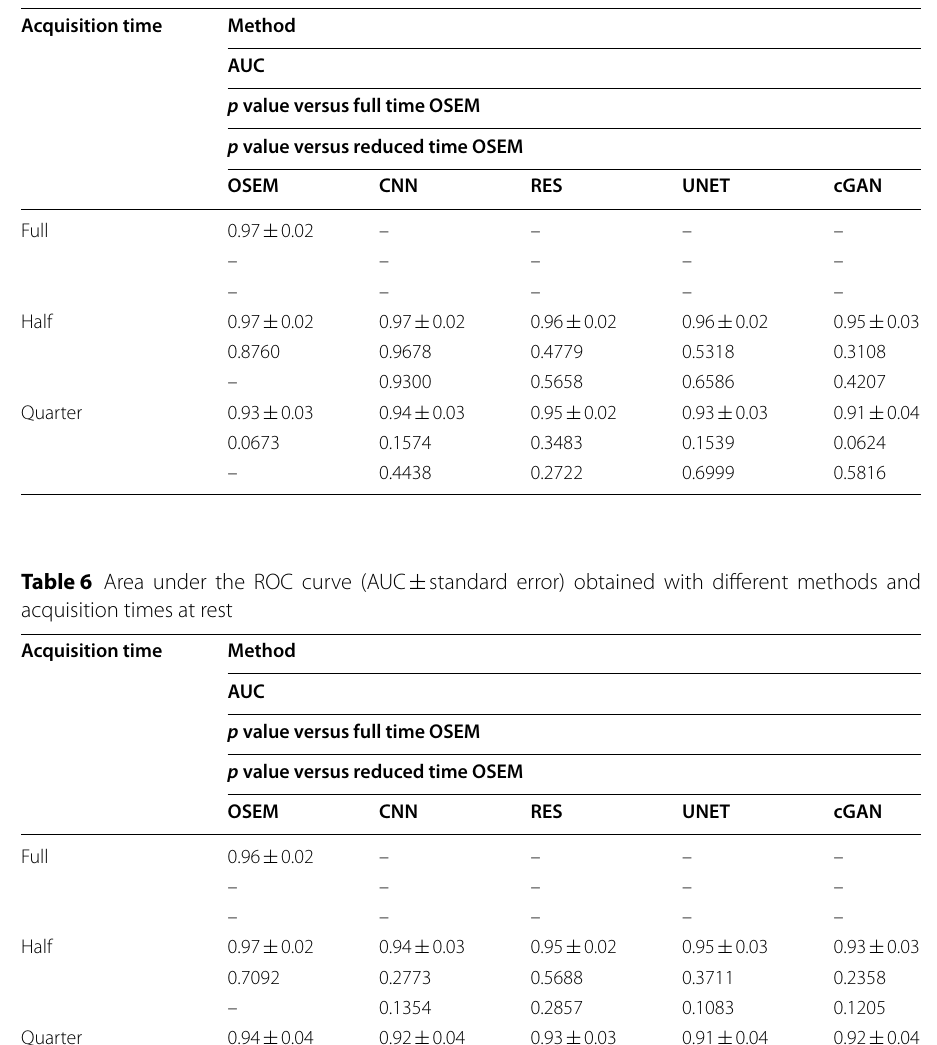
standard error) obtained with different methods and ±